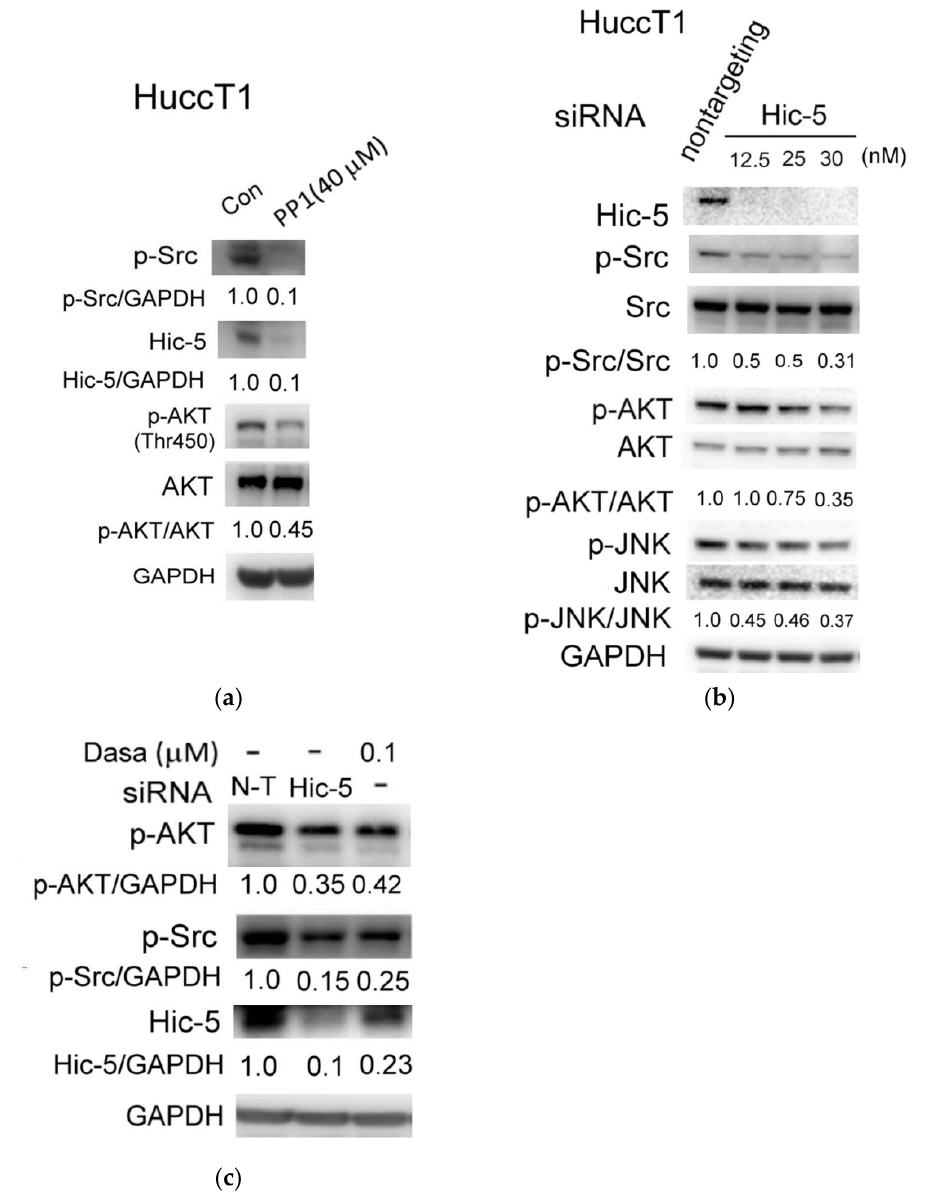
Figure 3. Delineating Src-Hic-5-AKT/JNK signaling in HuCCT1. HuCCT1 cells were treated with Src inhibitor (PP1) ( a ) and Dasatinib (Dasa) ( c ) at indicated concentration; HuCCT1 cells were transfected with Hic-5 siRNA at indicated concentration for 48 h ( b ). Western blot of indicated molecules were performed using GAPDH as an internal control. The numbers below the indicated blots were the relative intensity of each active signaling molecule normalized with their inactive forms or GAPDH as indicated. The data shown are averages of two reproducible results with coefficient of variation (C.V.) as 7.0%.